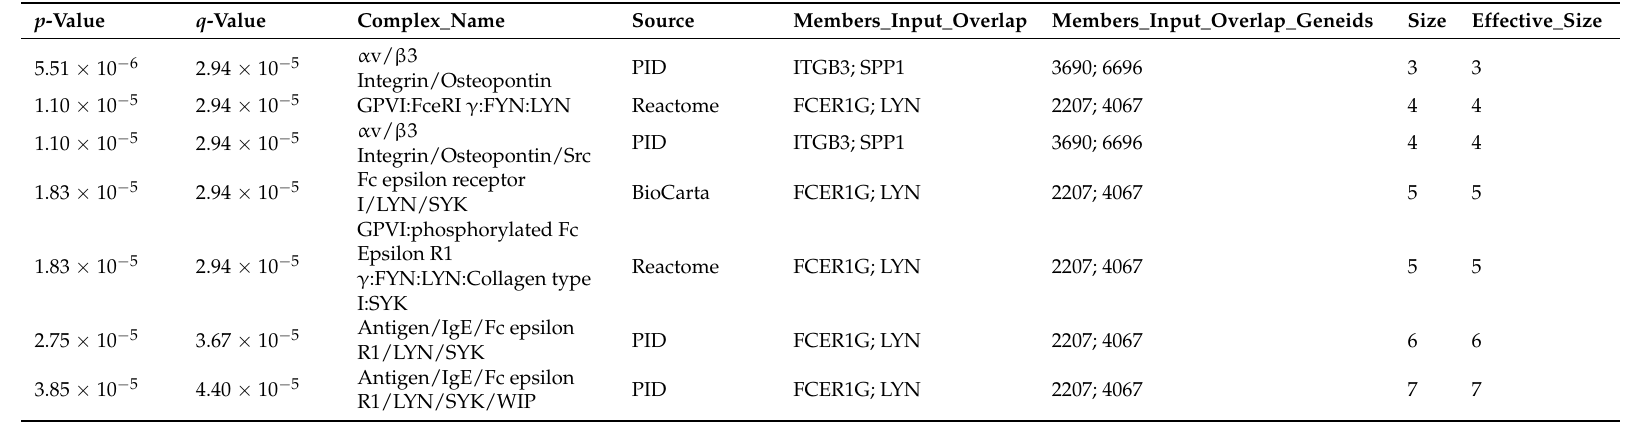
Table 2. The list of proteins complexes from Reactome, PID (Pathway Interaction Database) and BioCarta databases, that included protein products of differently expressed genes that belongs to the “positive regulation of metabolic process” and “regulation of homeostatic